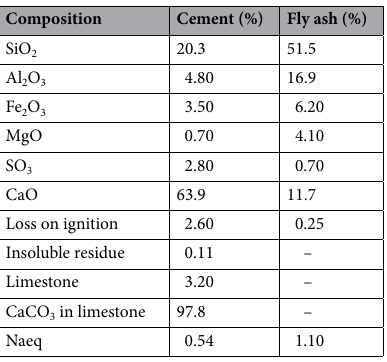
Table 1. Chemical composition of PC and class-F fly